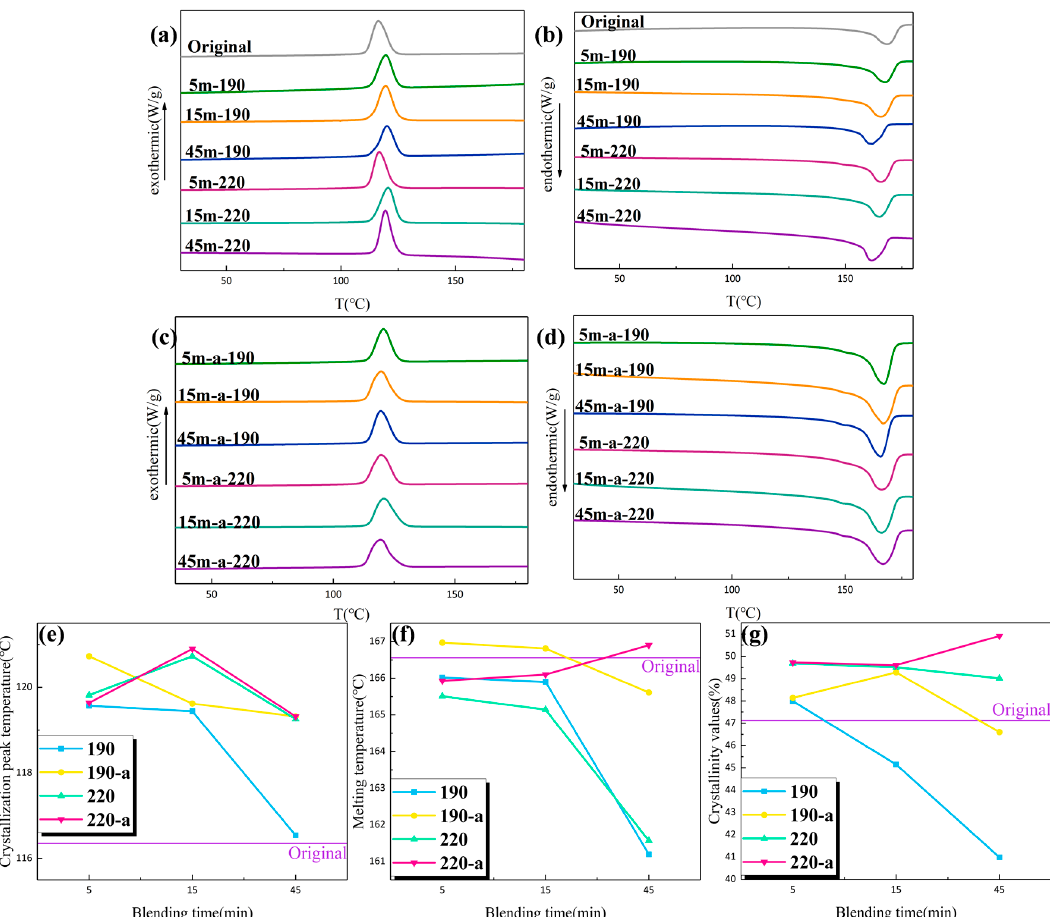
Figure 4. DSC curve of each sample. ( a ) and ( c ) are crystallization curves; ( b ) and ( d ) are melting curves, which were tested in the temperature range of 30 °C to 180; ( e ), ( f ) and ( g ) are crystallization peak temperature, melting temperature and crystallinity values of the material of each sample (the exothermic and arrow indicate the direction of exothermic peak; the endothermic and arrow indicate the direction of the endothermic peak).